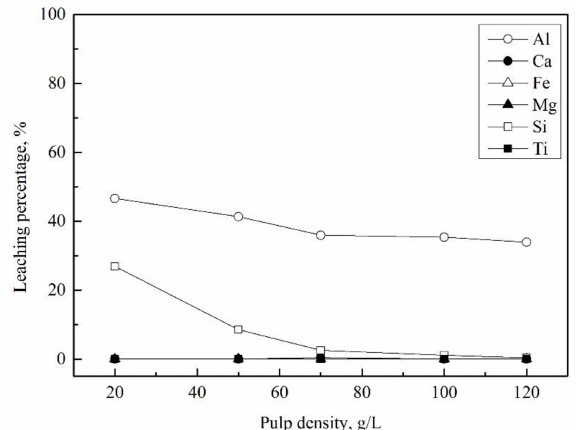
Figure 8. The effect of pulp density on the leaching of the oxides from the mechanically activated dross in a 5 M NaOH solution at 50 ◦ C. (reaction time: 2 h, stirring speed: 200 rpm).